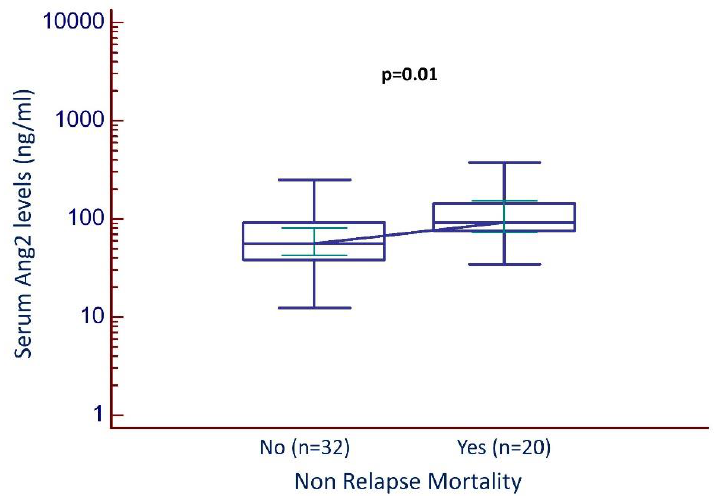
Figure 1. Serum Ang2 levels and non-relapse mortality (all patients).